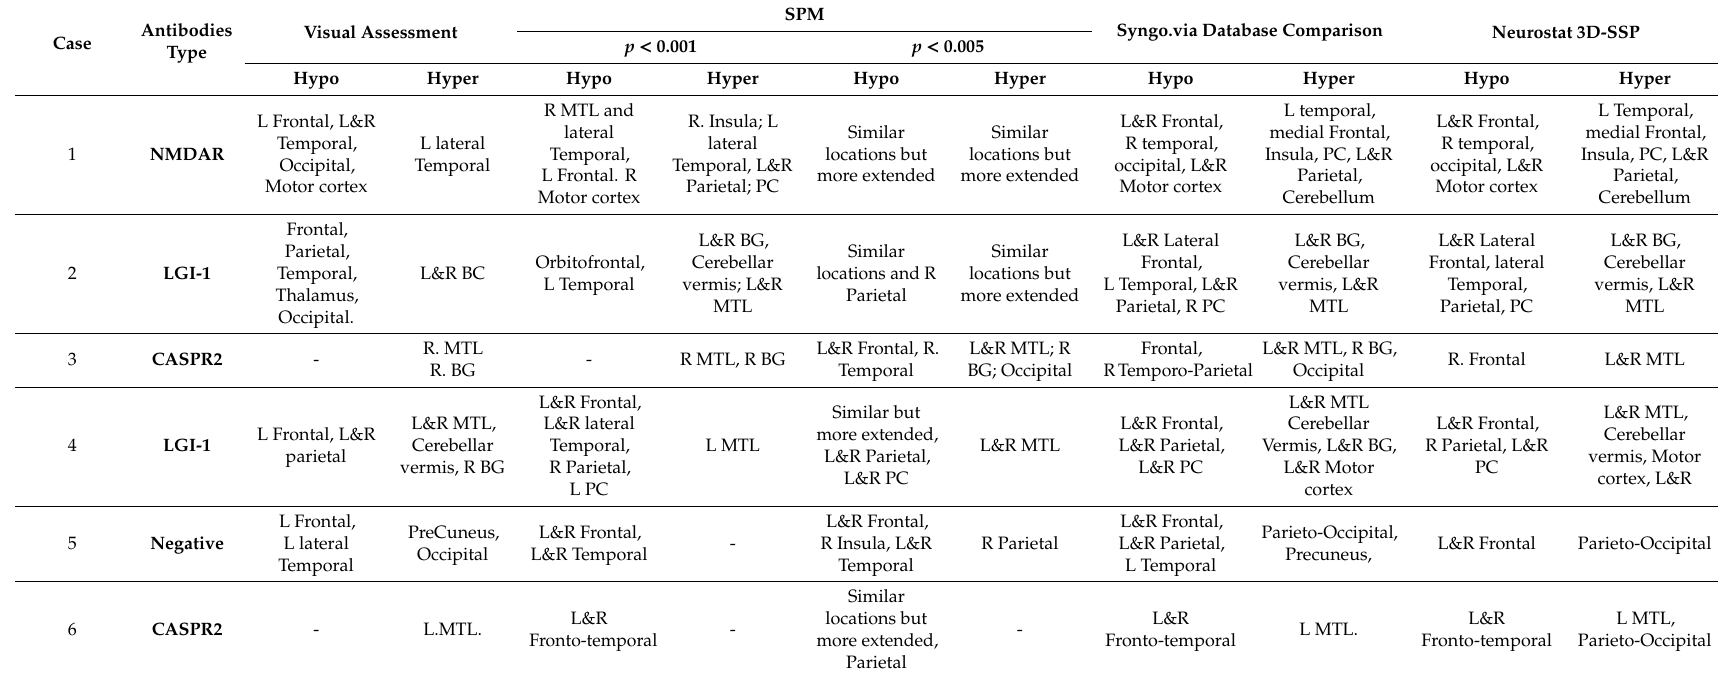
Table 2. Brain FDG-PET